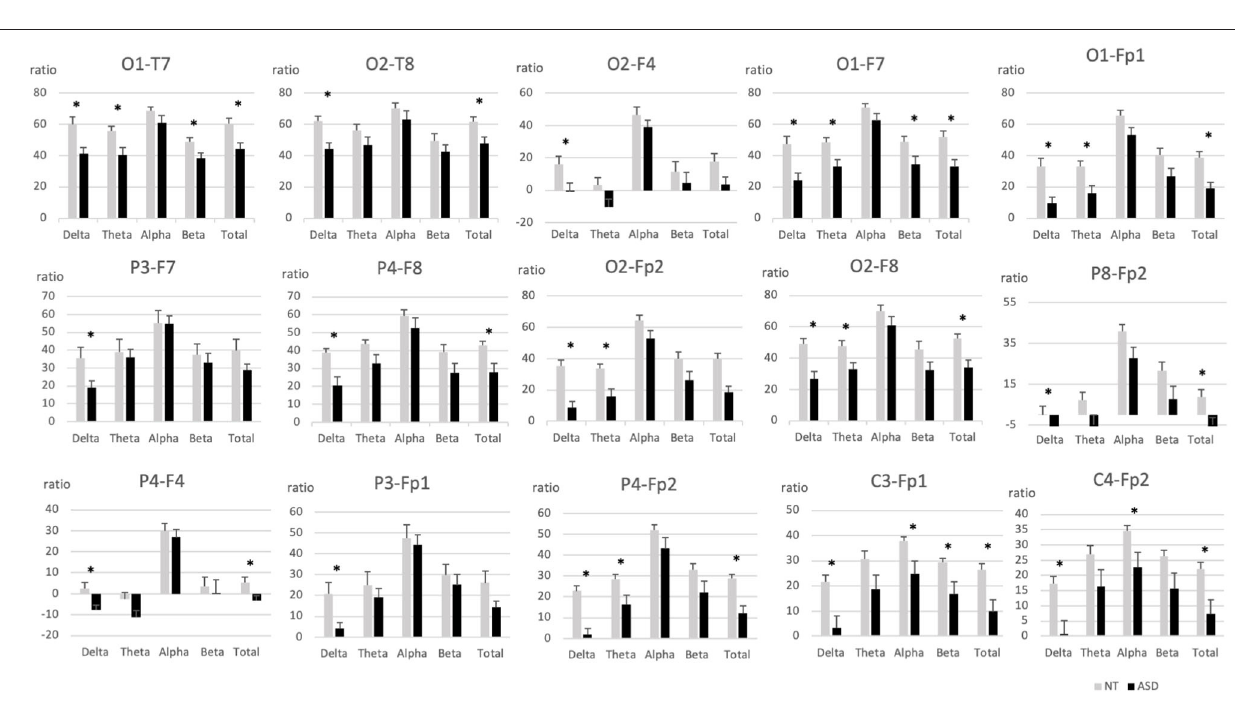
C4-F4 recording sites in the alpha frequency range ( Figure 4C